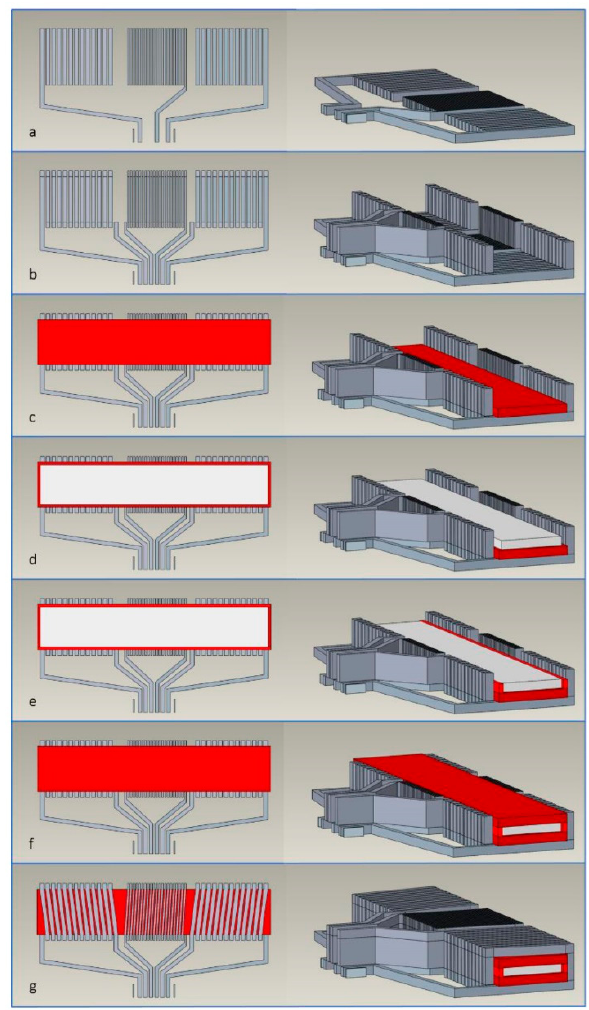
Figure 16. The producing process of the printed fluxgate magnetometer. ( a ) Printing the bottom conductive layer; ( b ) Printing the conductive vias; ( c ) Printing the bottom insulating layer; ( d ) The mounting and attachment of magnetic core; ( e ) Printing the insulating walls; ( f ) Printing the top insulating layer; ( g ) Printing the top conductive layer.